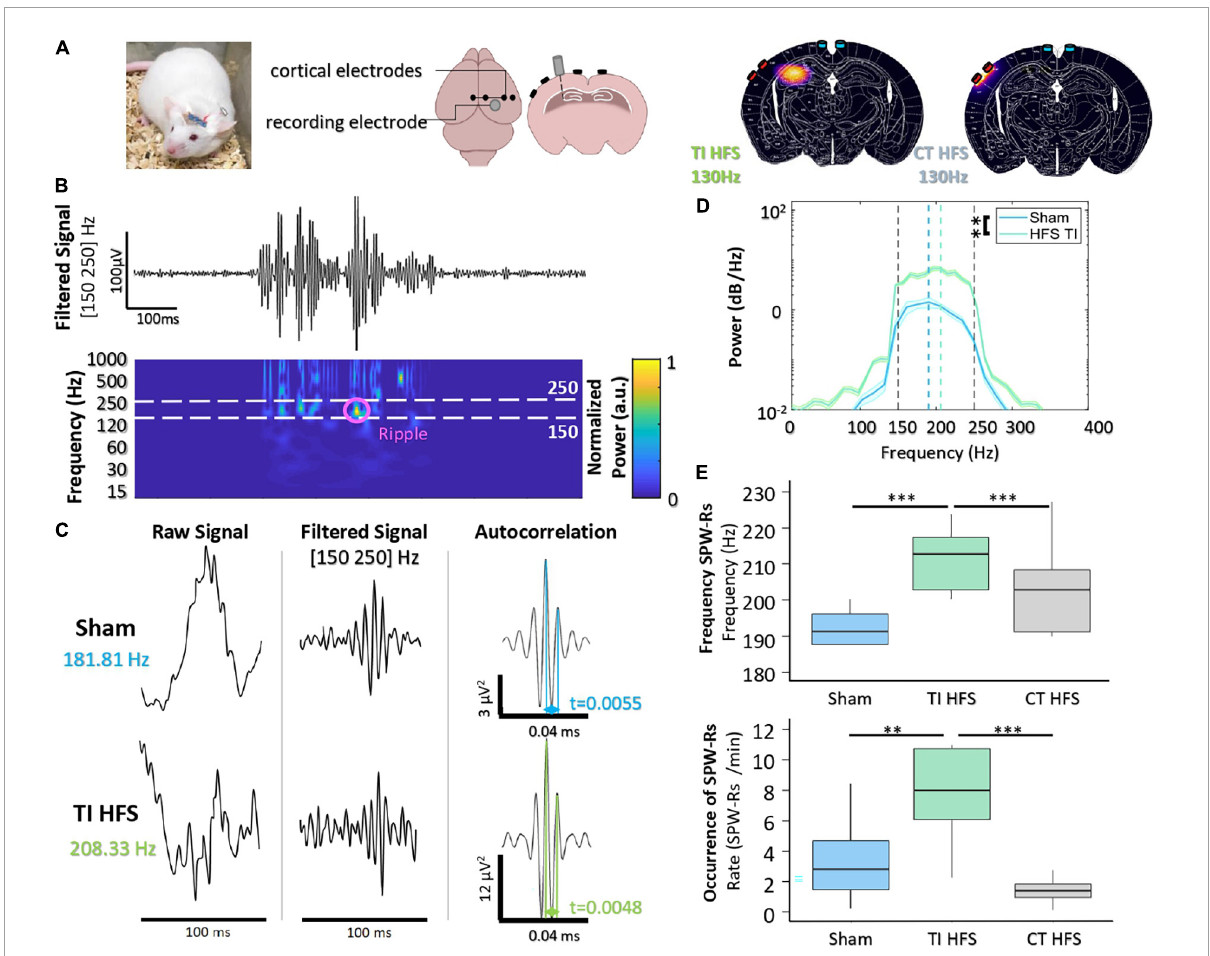
FIGURE2 Focal hippocampal stimulation induces SPW-Rs. (A) Mice are implanted with depth-electrode to induce epileptiform activity. Finite element model of TI-HFS and CT-HFS. It shows the creation of a hot spot of stimulation in the hippocampus via TI compared to the cortical stimulation with HFS. (B) Raw recording and time-frequency plot of activity in the hippocampus showing the identification of SPW-Rs in the frequency band [150–250 Hz]. (C) Example SPW-Rs and the averaged autocorrelation from Sham and TI-HFS. The distance in time of the first and second peaks of the average autocorrelation shows SPW-Rs’ frequency. (D) Analysis of the power spectral density to get the frequency of the recorded SPW-Rs ( ∗∗ p -value < 0.01). (E) Frequency and occurrence of SPW-Rs for TI-HFS (green), Sham (blue), and CT-HFS (gray) ( ∗∗∗ p -value <